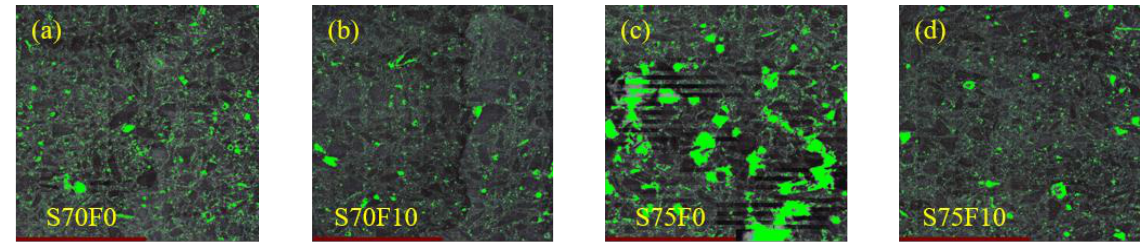
Figure 10. Pore structure analysis of specimens ( a ) S70F0; ( b ) S70F10; ( c ) S75F0; ( d ) S75F10.